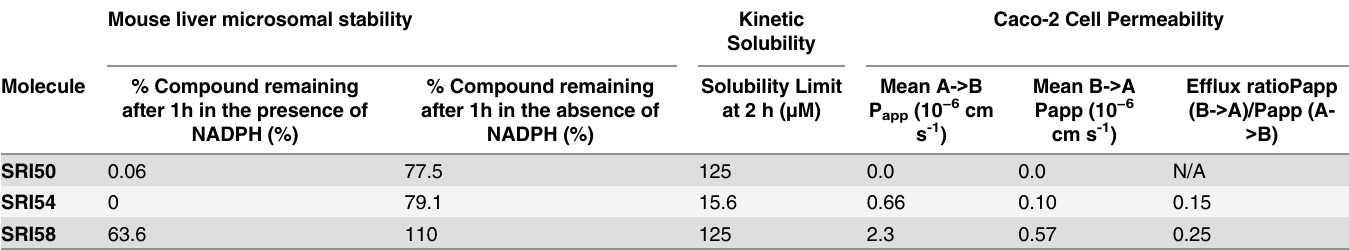
Table 3. Physiochemical and ADME data. For microsomal stability, verapamil was used as a high-metabolism control (0.24% remaining with NADPH) and warfarin was a low-metabolism control (85% remaining with NADPH). The kinetic solubility limit was the highest concentration with no detectable precipitate. For Caco-2 cell permeability, compounds at a concentration of 10 μ M were incubated for 2 h. P app = apparent permeability coefficient. All compounds showed poor recovery due to either low solubility or non-specific binding. Ranitidine, warfarin and talindol were used as low permeability, high permeability and P-gp efflux, controls respectively.